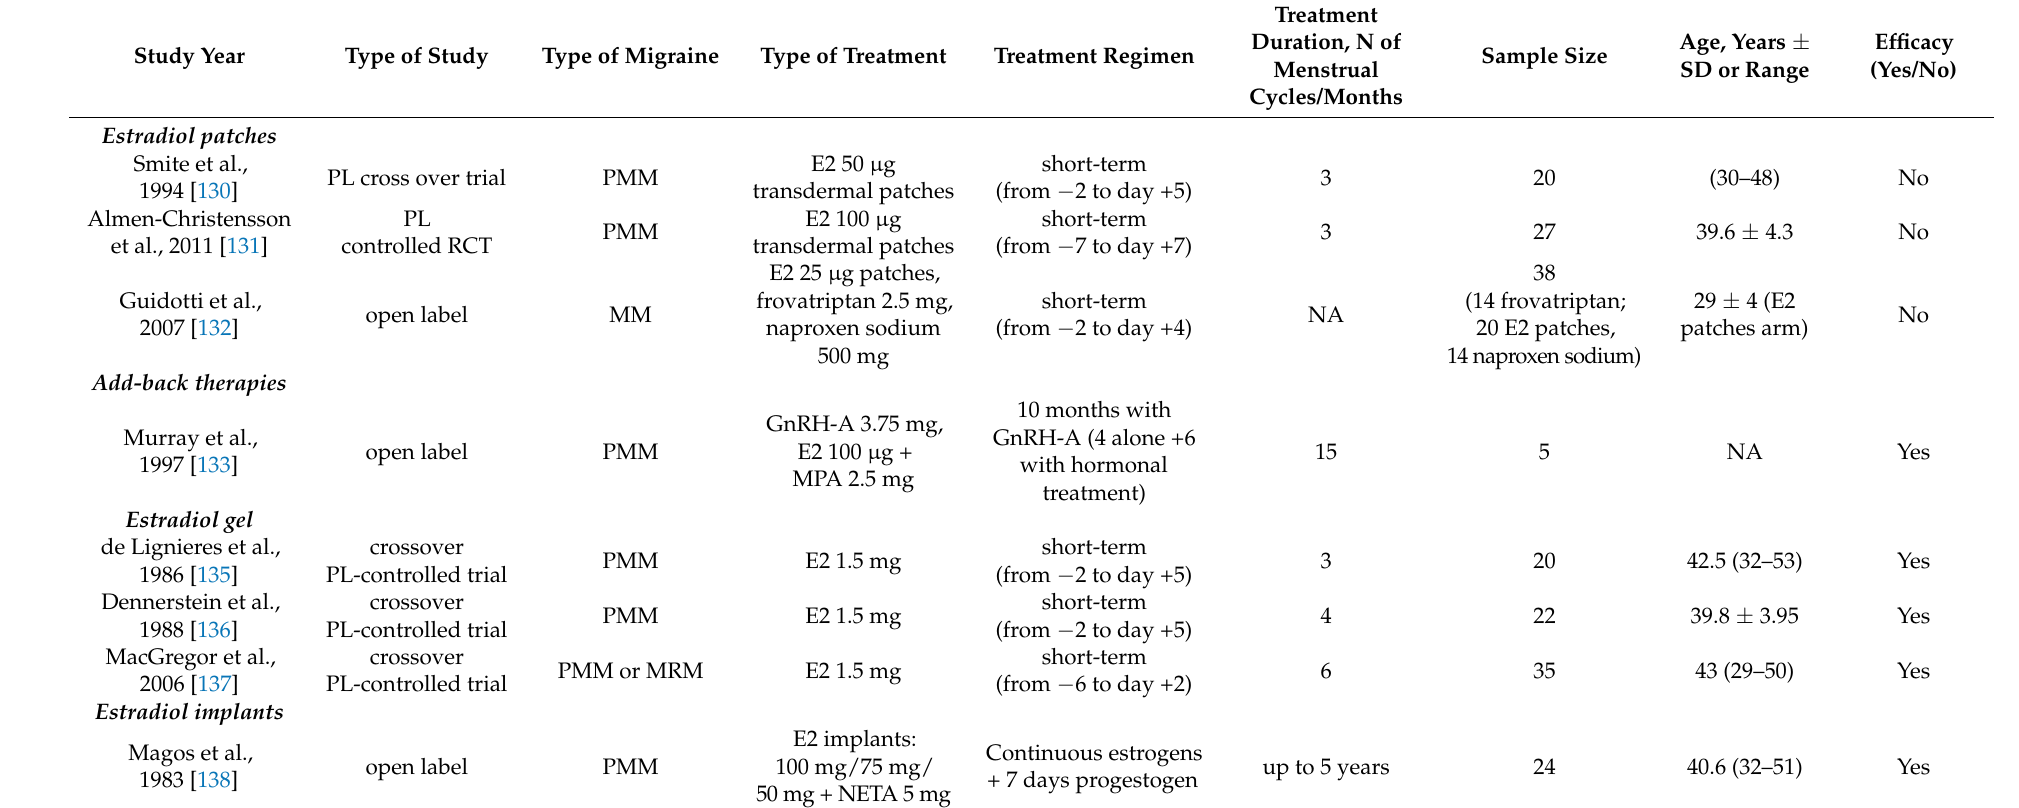
Table 2. Main characteristics of the studies on estrogen use in the treatment of